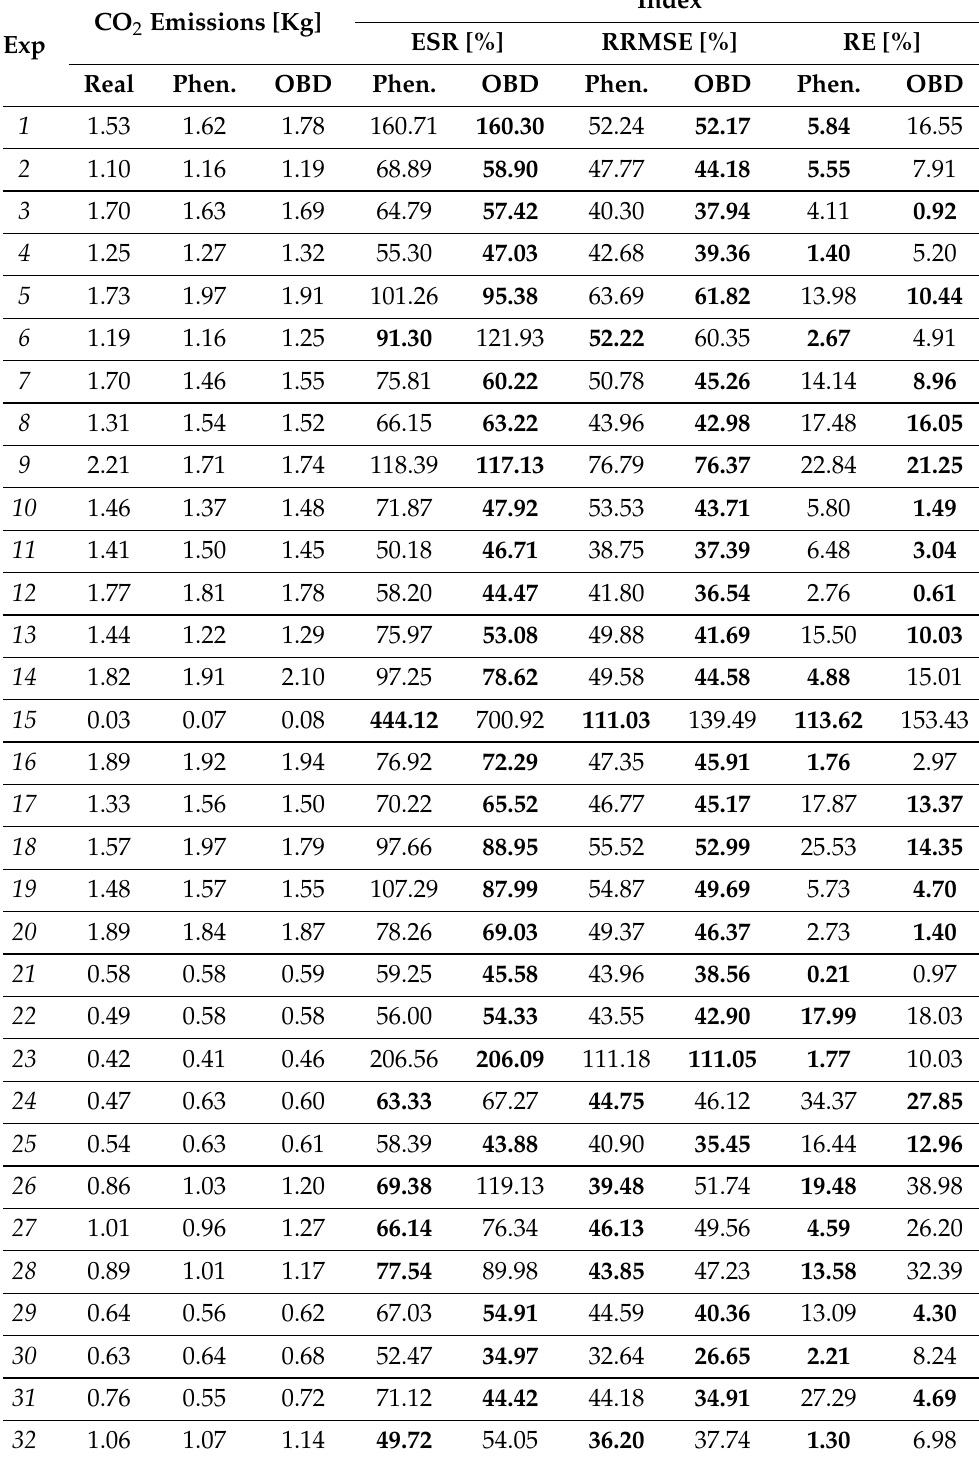
Table A3. Emissions—experiments